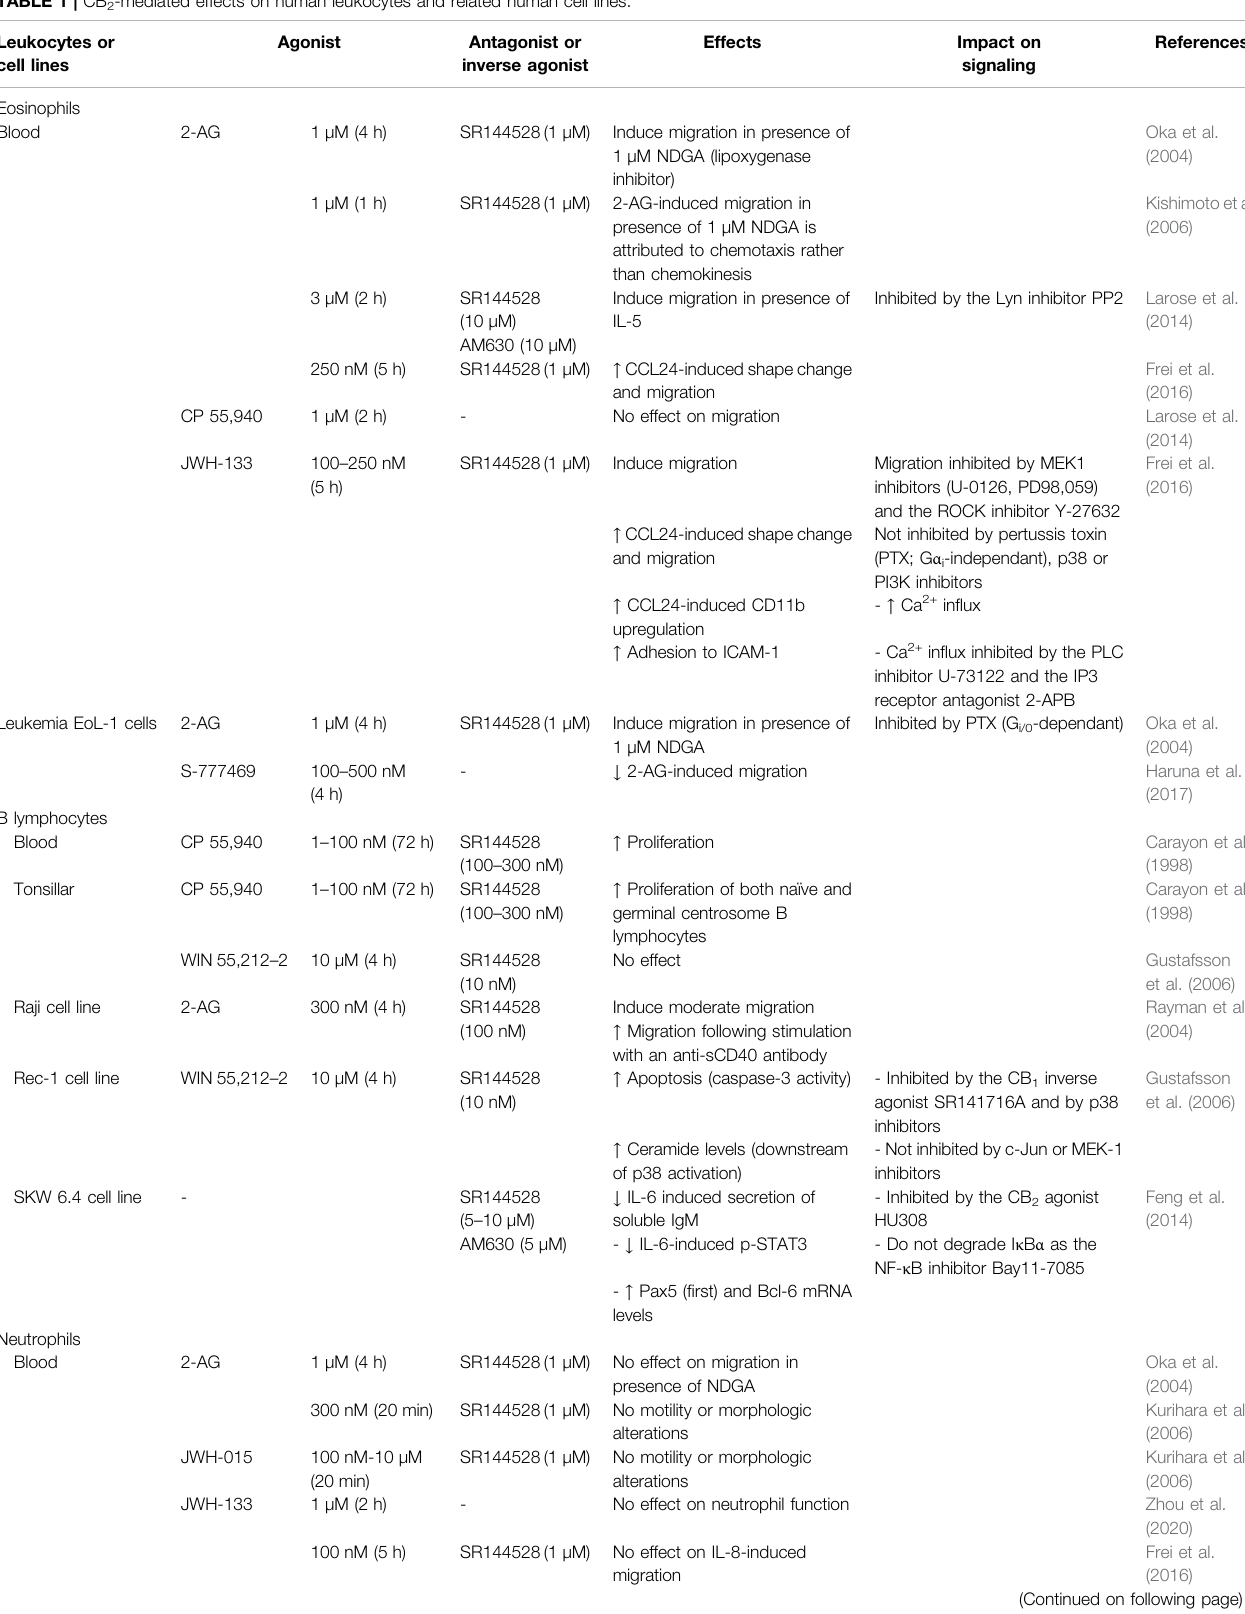
TABLE 1 | CB 2 -mediated effects on human leukocytes and related human cell